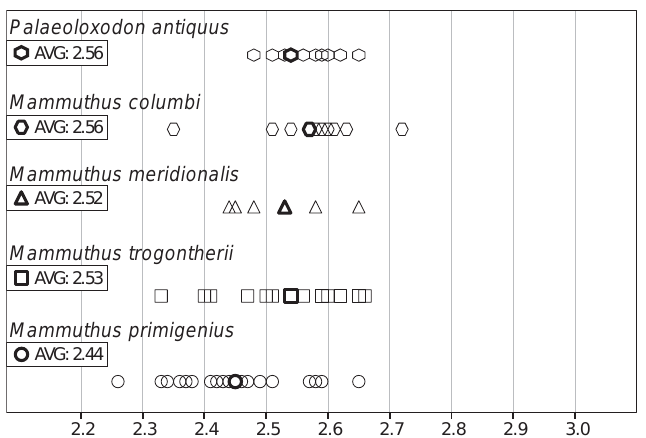
Fig. 6. Femur length vs. skeletal shoulder height ratio of selected probos- cideans based on the data collected in this study (Appendix 1, SOM: table 2; AL unpublished data).